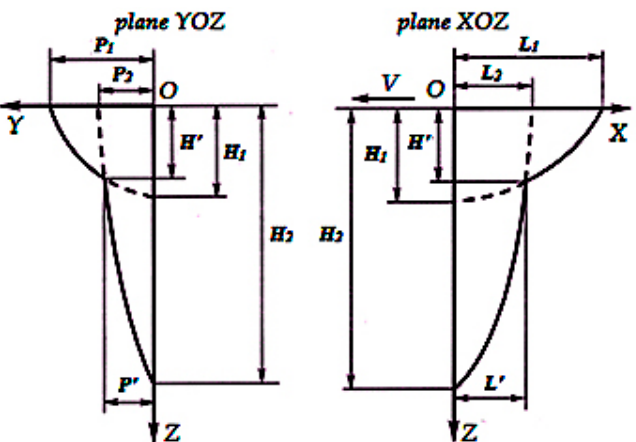
Figure 3. Schematic division of the crystallization front into components: Р ’ , H’ , and L’ —intersection point coordinates for the two curves (inflection point); Р 2 , H 1 , and L 2 — values at which the curves intersect relevant coordinate axes; P 1 —corresponds to the value of the weld half-width, H 2 —corresponds to the weld depth; L 1 —numerically equal to the length of the welding bath on the surface.